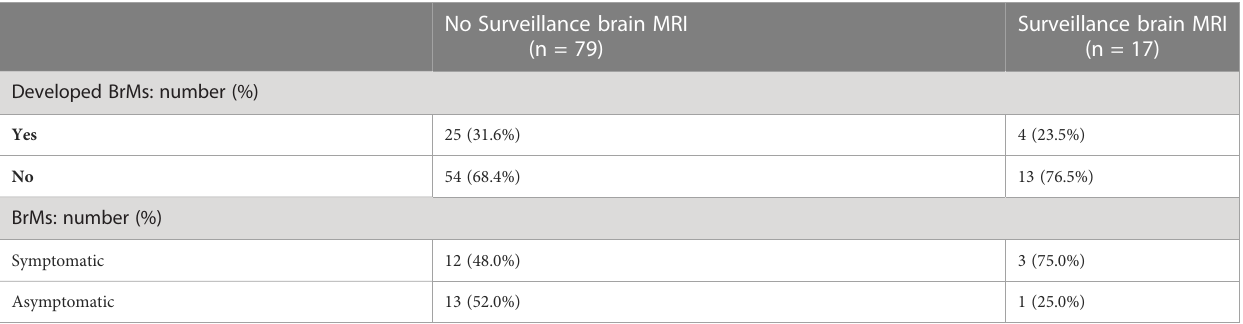
No Surveillance brain MRI (n = 79)